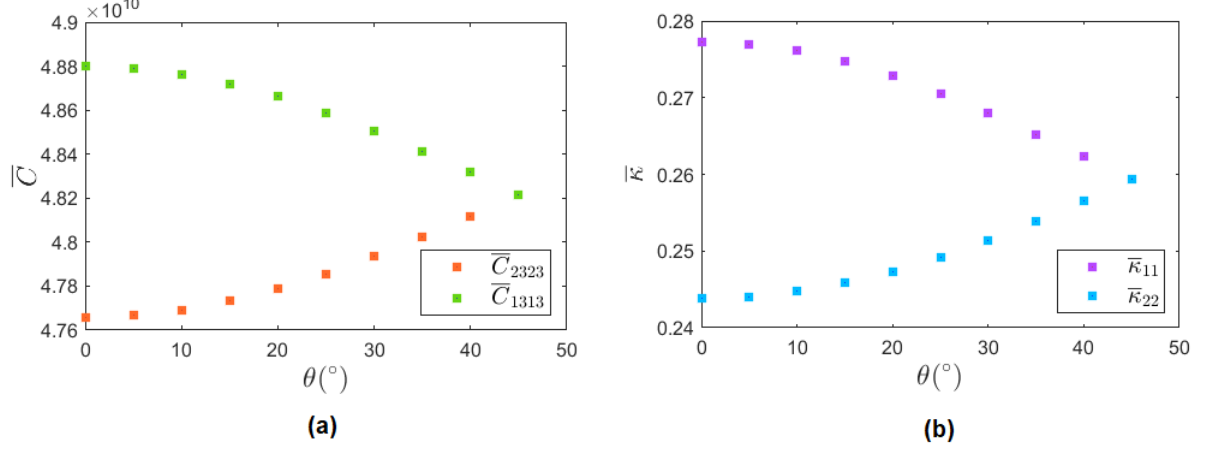
Figure 12. Effective coefficients for different θ alignments, (a) elastic coefficients C 1313 and C 2323 , (b) thermal conductivity coefficients κ 11 and κ 22